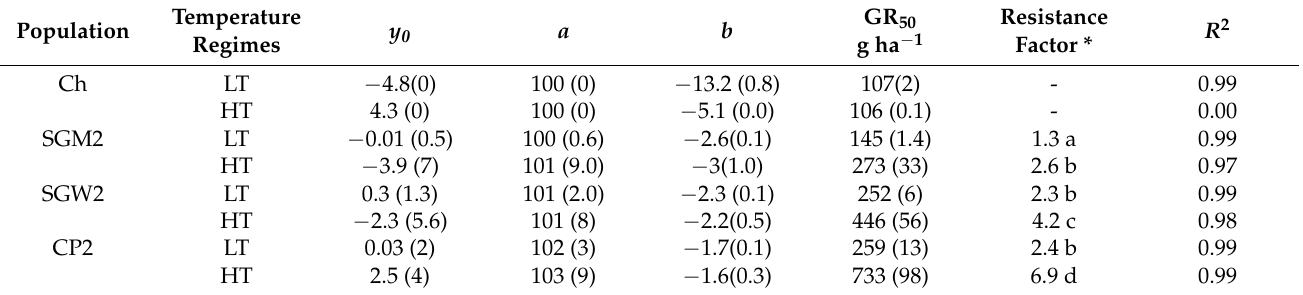
Figures in parentheses indicate the standard error of means (±); LT: low temperature; HT: high tem- perature; y 0 = bottom of the curve; a = difference between the top and bottom of the curve; b = slope of the curve. * Values with different letters are significantly different at 5% level of significance on the basis of the t -test.